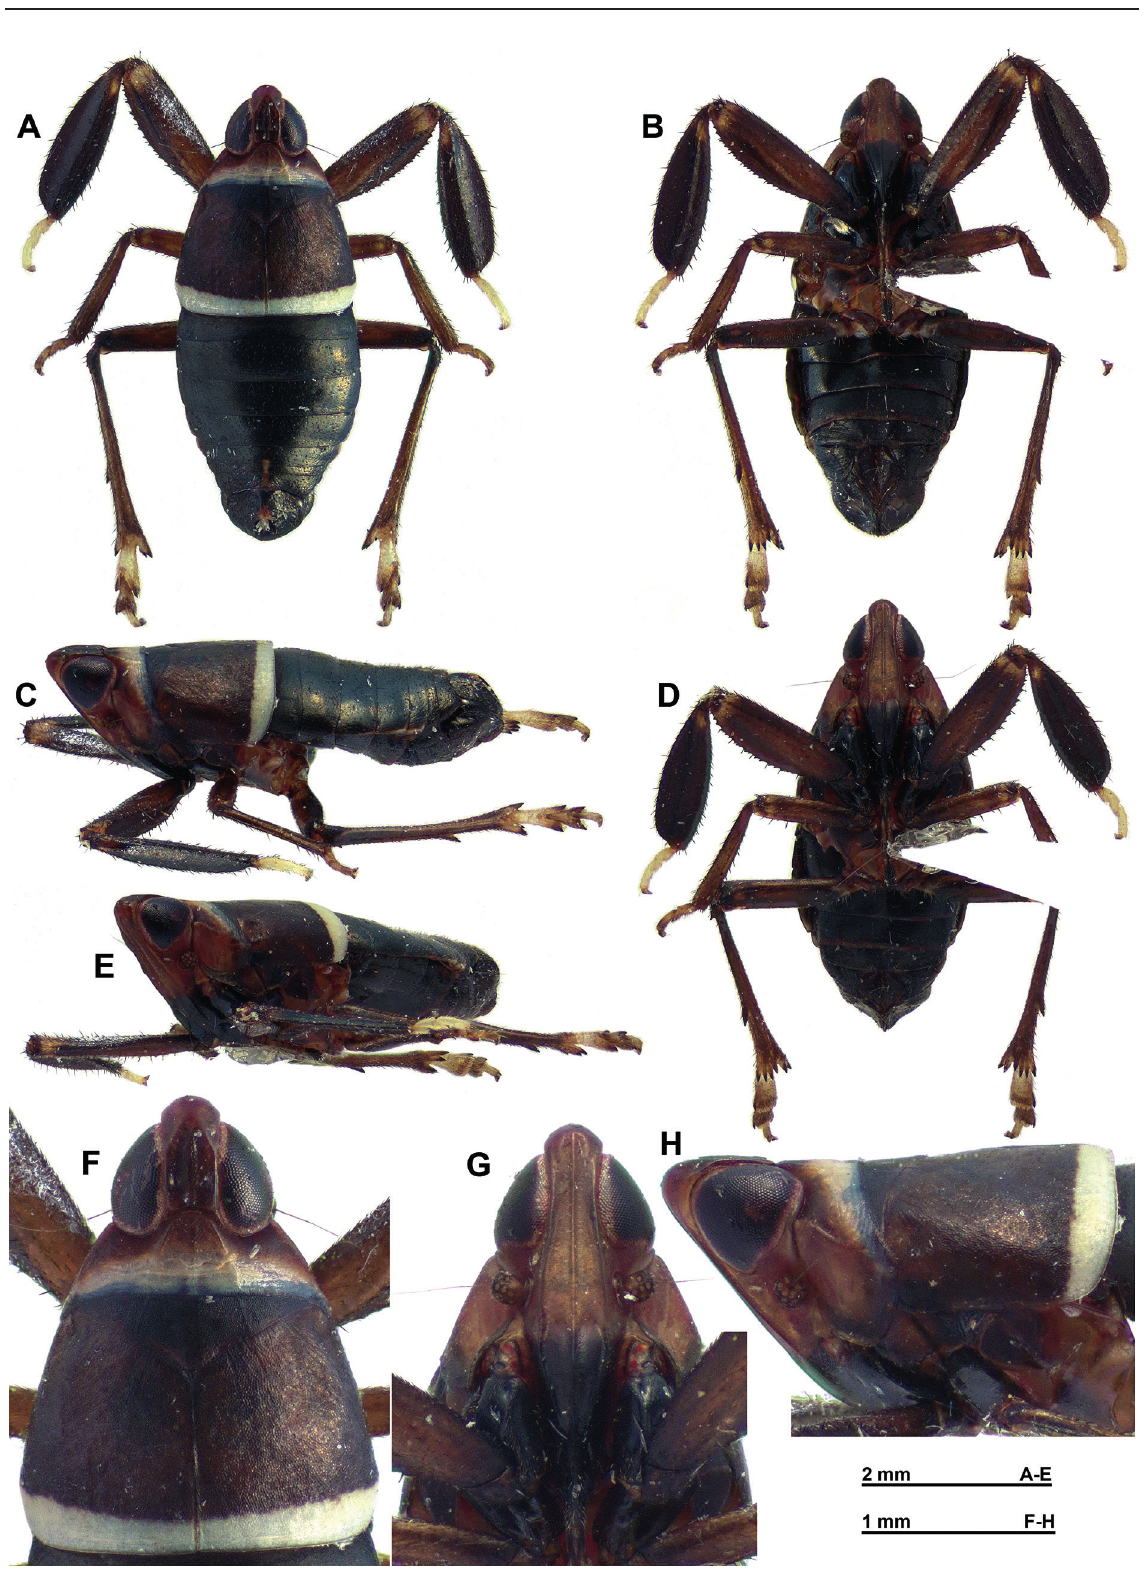
Fig. 3. Cleotyche ( Cleotyche ) christinae sp. nov., ♀, paratype (QM). A . Habitus dorsal view. B . Habitus, ventral view. C . Habitus, lateral view. D . Habitus, perpendicular view of frons. E . Habitus, anterolateral view. F . Head and thorax, dorsal view. G . Frons, perpendicular view. H . Head and thorax, lateral